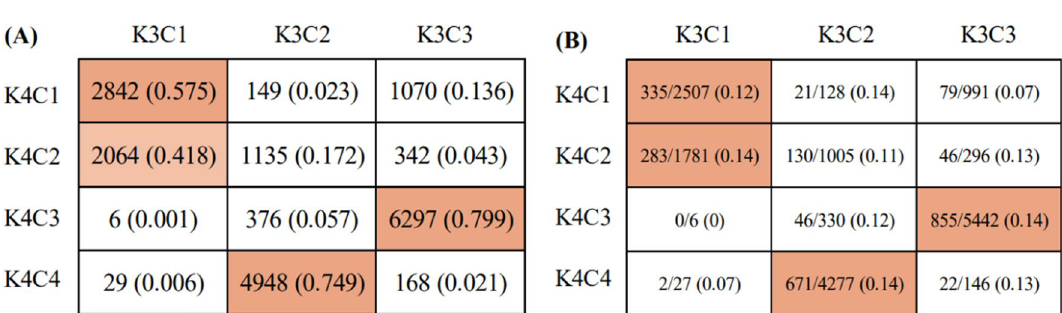
Figure 2. Four subgroups established by K-means clustering. ( A ) Four subgroups were characterized based on seven sepsis-related variables using one sample t -test. The brown box plot is about all subjects including healthy control and sepsis patients. Black middle, upper margin, and max lines in each boxplot indicate means, one standard deviation (SD), and 2 SD deviation levels. ( B ) Beta-coefficients were measured from multivariate logistic regression. Brown bar was made by logistic regression for all subjects. Other bars (yellow, light cyan, red, and green) were curated by logistic regression for each cluster-specific subjects. A red asterisk indicates p-value less than 0.001.